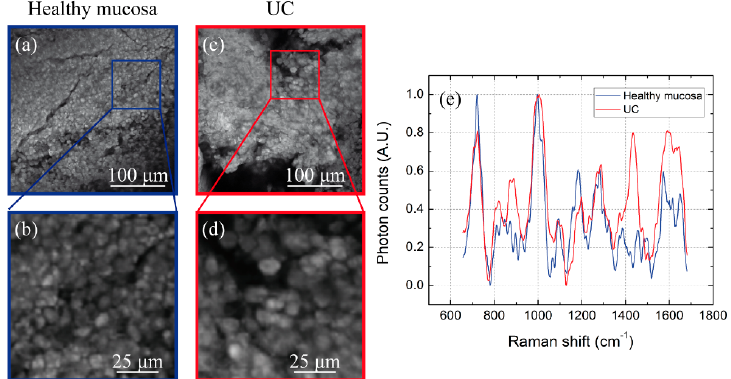
Figure 7. ( a ) TPEF images of healthy mucosa (blue) with ( b ) magnified detail, ( c ) UC tissues (red) with ( d ) magnified detail, ( e ) average Raman spectra collected in the magnified regions.